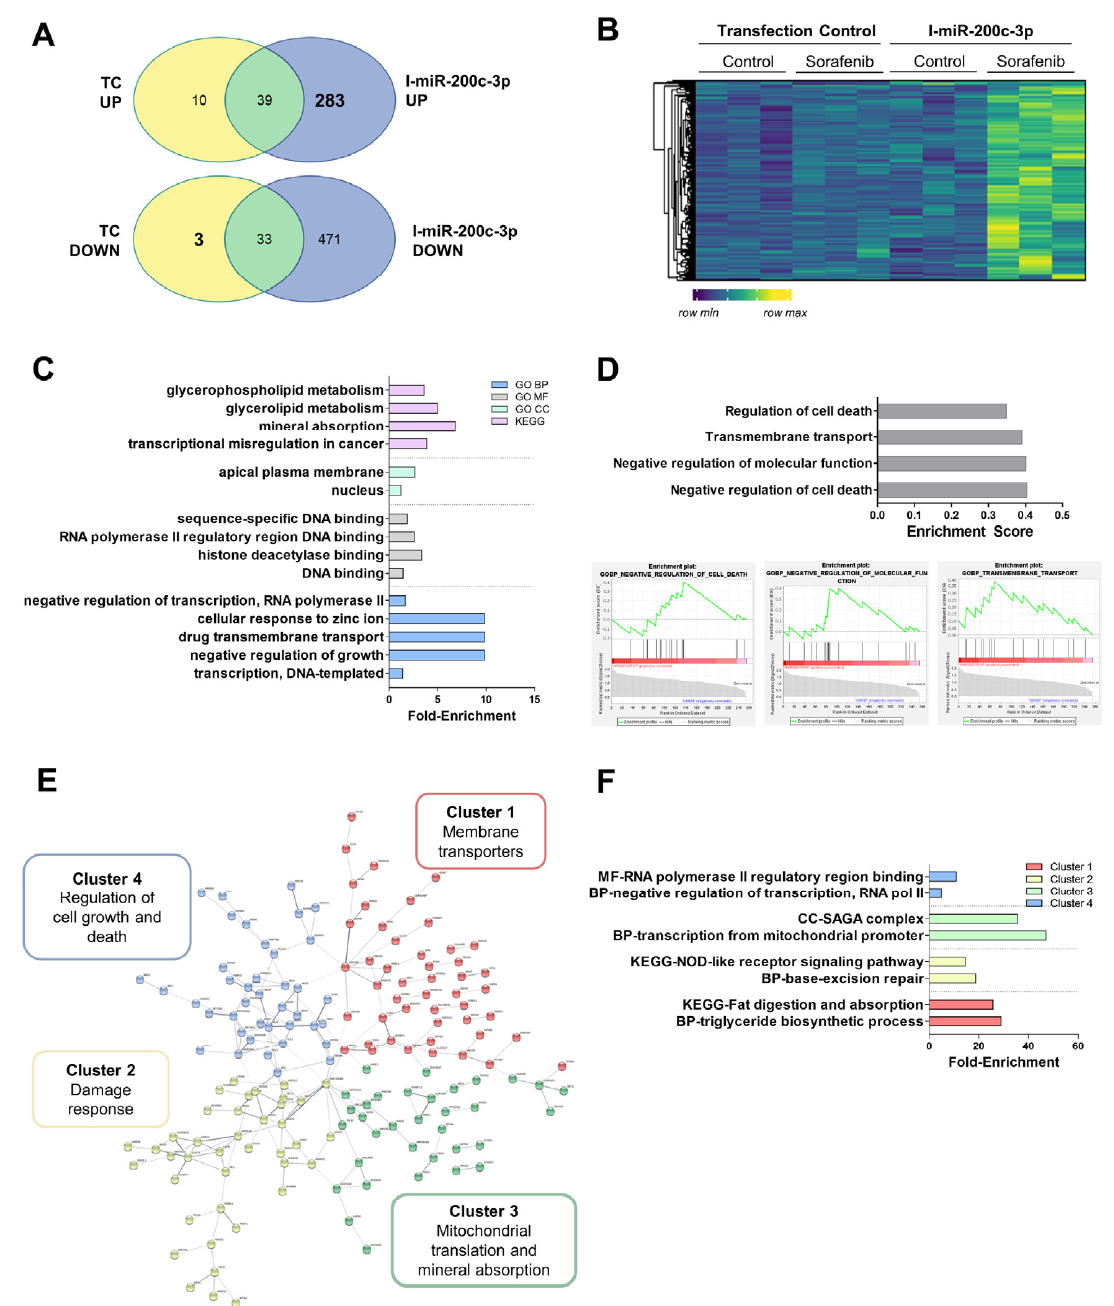
Figure 6. RNA-sequencing data of miR-200c-3p down-regulation in HepG2 cells showed increased damage response mechanisms. ( A ) Venn diagrams showing the mRNAs regulated upon miR-200c-3p inhibition (I-miR-200c-3p) compared to the transfection control (TC). ( B ) Heatmap of genes regulated by miR-200c-3p. ( C ) Ffold-enrichment values of the top five most significantly enriched GO BP, MF, CC, and KEGG pathways. ( D ) Top 10 significant hallmarks GSEA up-regulated after I-miR-200c-3p. Plots were provided for the three most enriched terms. ( E ) Diagram showing the clustering of STRING analysis. ( F ) Fold-enrichment values of the top two most significantly enriched terms in either the GO BP, MF, CC, or KEGG pathways in each STRING cluster. Experiments were carried out as three independent